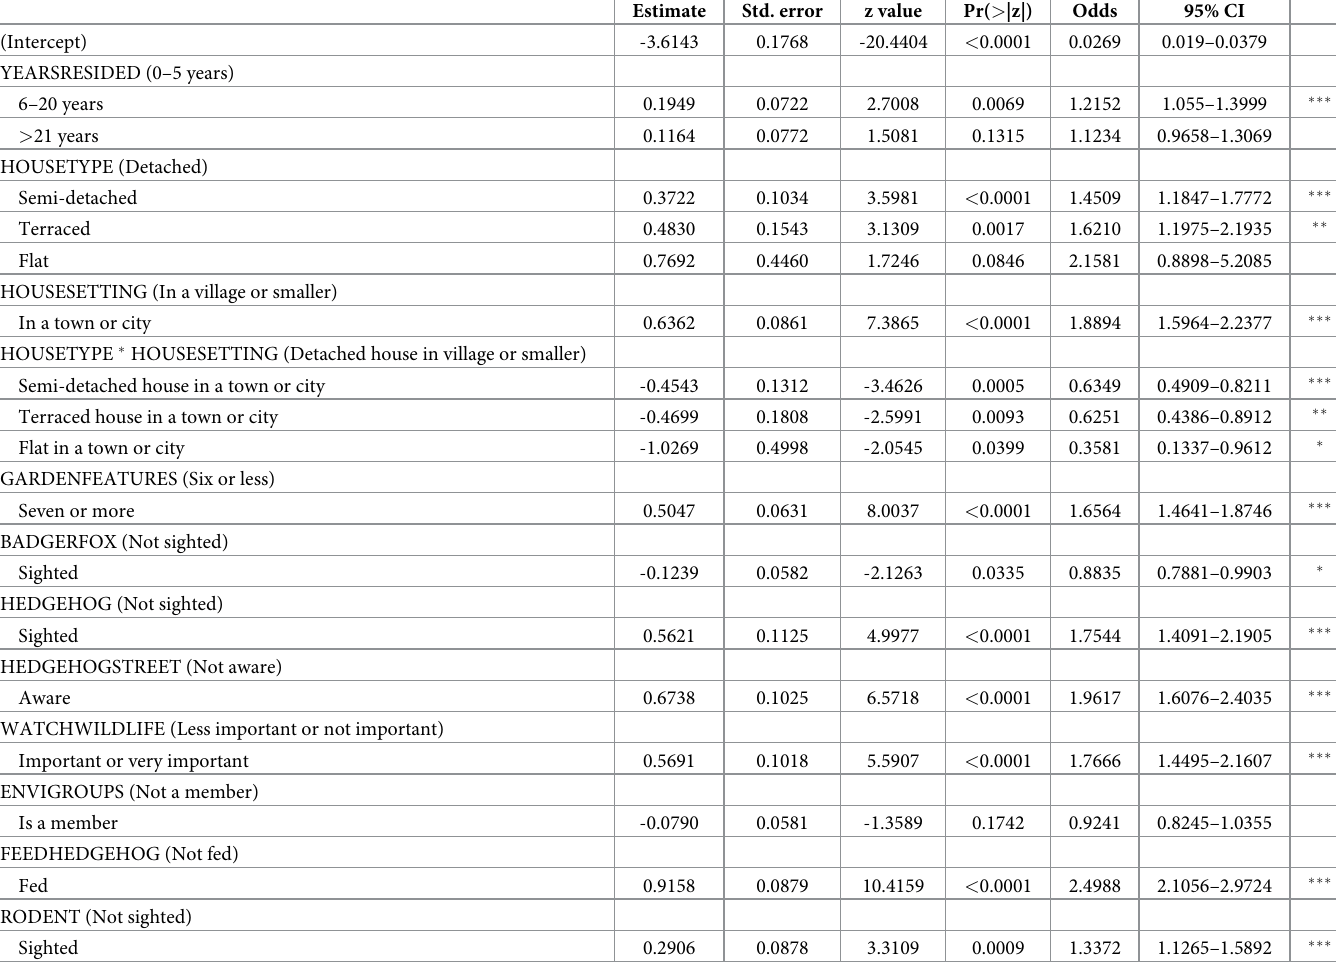
Table 3. Summary of the binary logistic regression analysis examining the effects of garden- and householder-related variables on the respondent’s decision to make a hedgehog highway (HIGHWAY) (N =